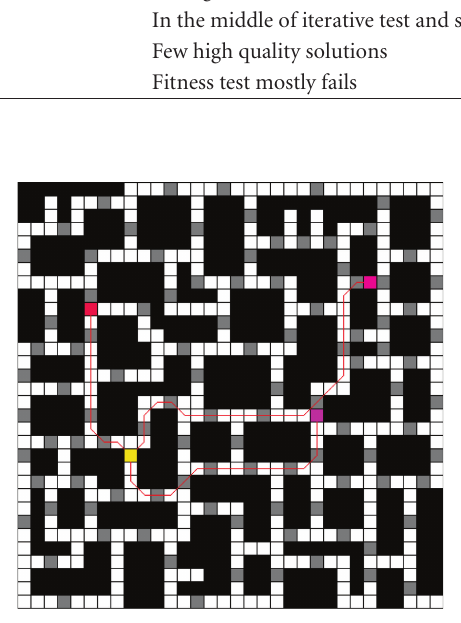
Figure 9: Combine force strategy. Figure 10: Trap